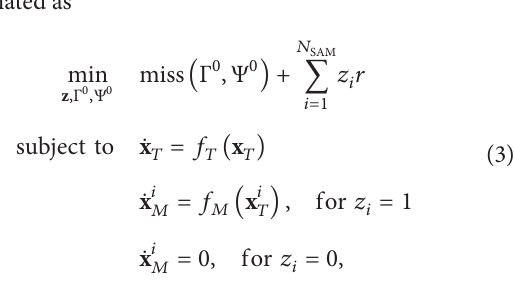
apogee altitude, velocity, reentry angle, and heading.